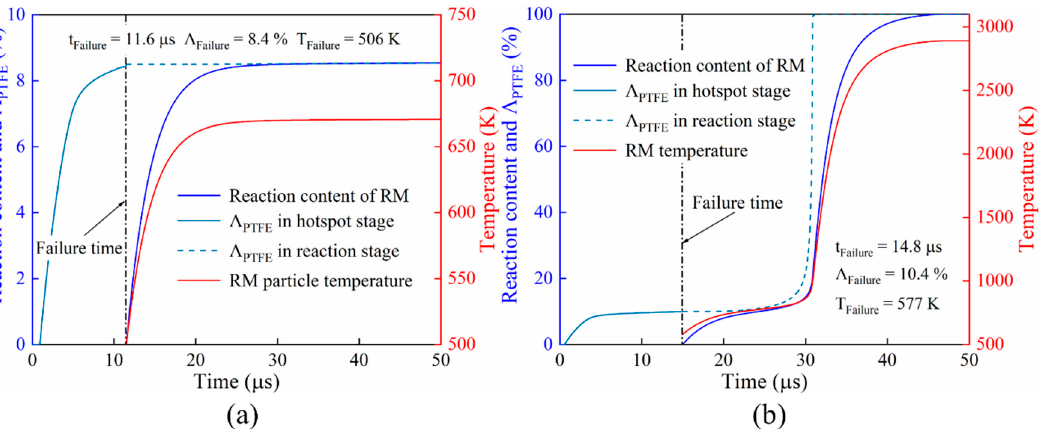
Figure 7. Reaction content profiles of two typical kinds of reacting particles: ( a ) partially reacted particle, and ( b ) completely reacted particle. Note: t Failure , Λ Failure , T Failure represent failure time, PTFE decomposition extent, and particle average temperature at the failure time, respectively.